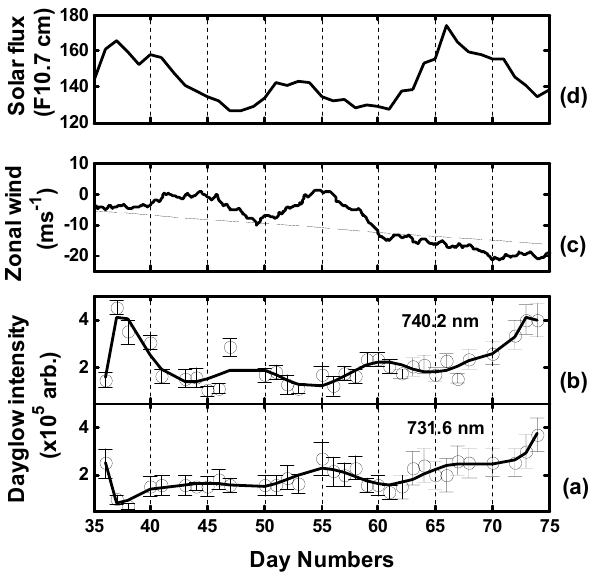
Fig. 1. Top two panels show the day-to-day variation of the mean F10.7cm solar flux and the zonal wind velocity with its linear-fit trend, respectively. Bottom two panels show the day-to-day varia- tion of the mean OH (8–3) dayglow emission intensities at 740.2nm and 731.6nm, including their best-fit